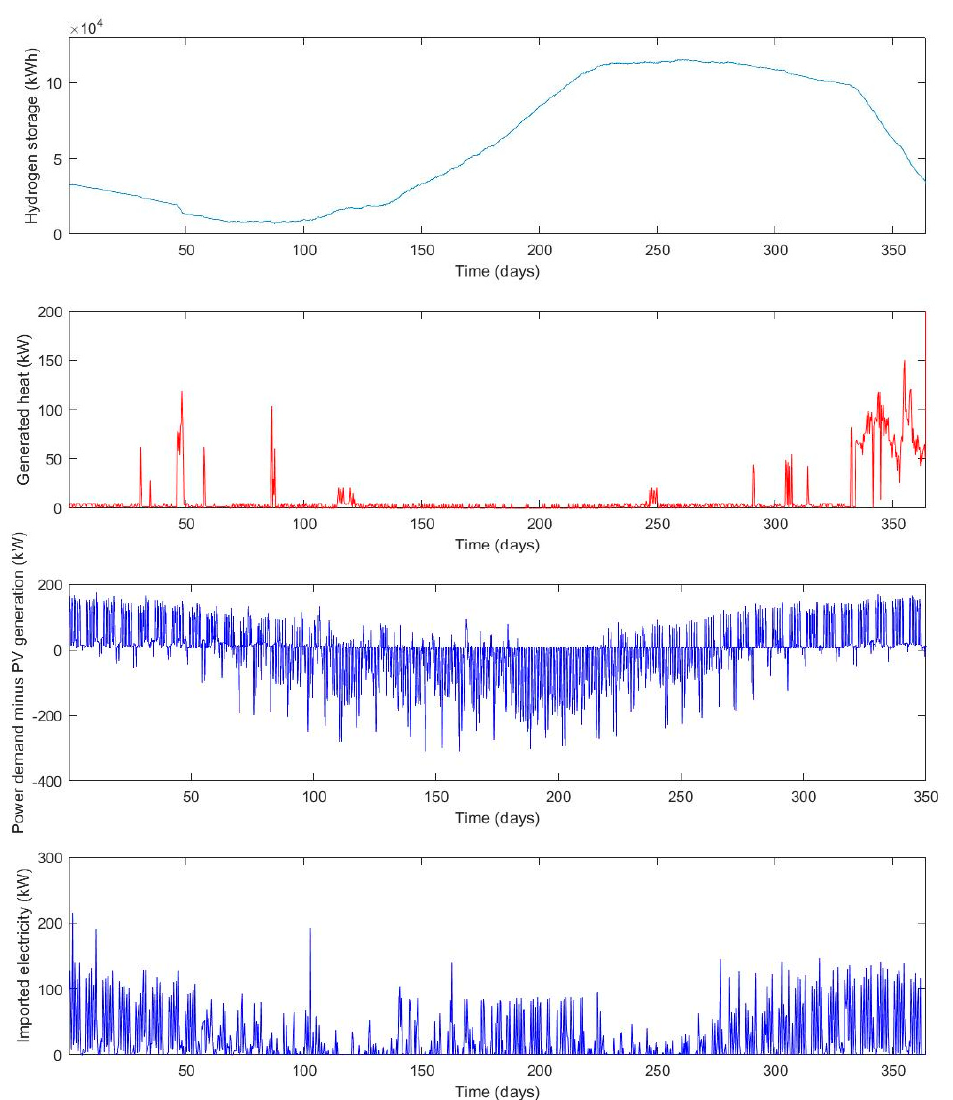
Figure A3. Optimal operation of a 20/80 kW RSOC system with 3000 m 2 solar PV panel.